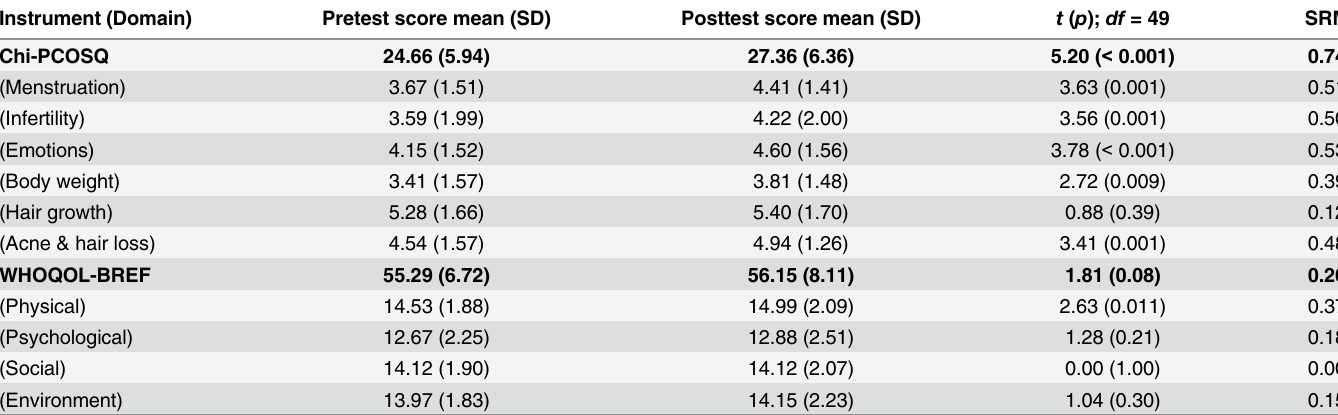
Table 2. Responsiveness of Chi-PCOSQ and WHOQOL-BREF (n = 50). Instrument